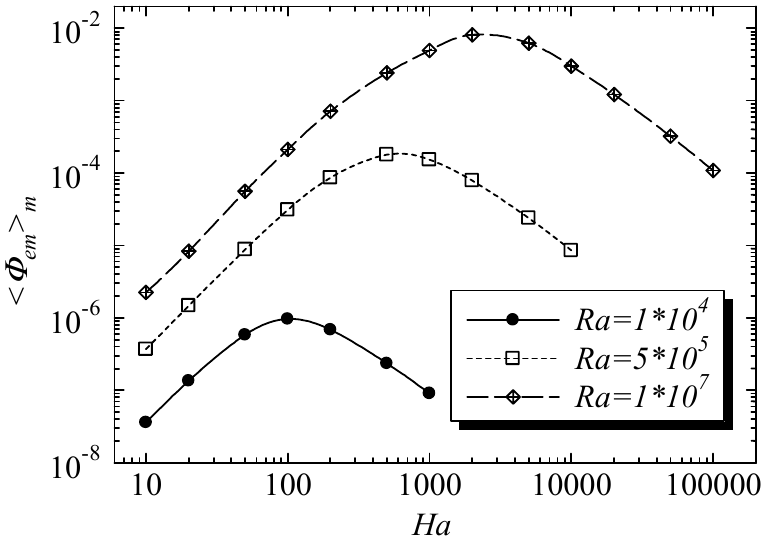
Figure 16. Dimensionless spatio-temporal average Joule heat < Φ em > m , which was small enough to be ignored.